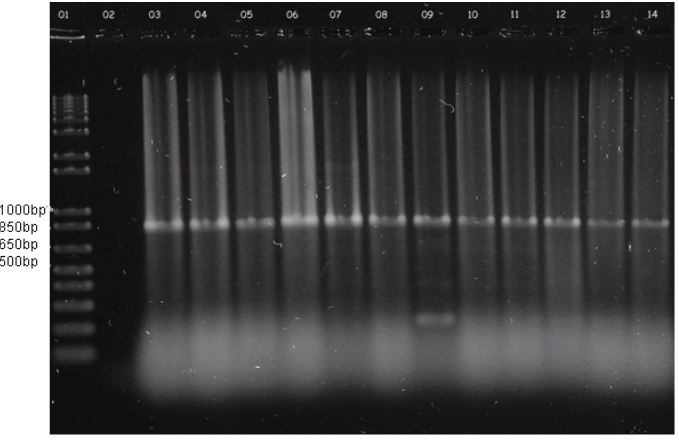
FIGURE 3 - Amplification of the gene eae from DNA of enteropathogenic Escherichia coli strains extracted from the feces samples of experimentally infected animals. 01: Base pair marker 1 Kb plus (Invitrogen). 02: Negative control (without DNA). 03: 01b/group B. 04: 02b/group B. 05: 03b/group C. 06: 05b/group B. 07: 06b/group C. 08: 07b/group C. 09: 03a/group C 48 h PI. 10: 02a/group B 48 h PI. 11: 02a/group B 72 h PI. 12: 05a/group C. 13: 03a/group C 72 h PI. 14: 04a/group B.